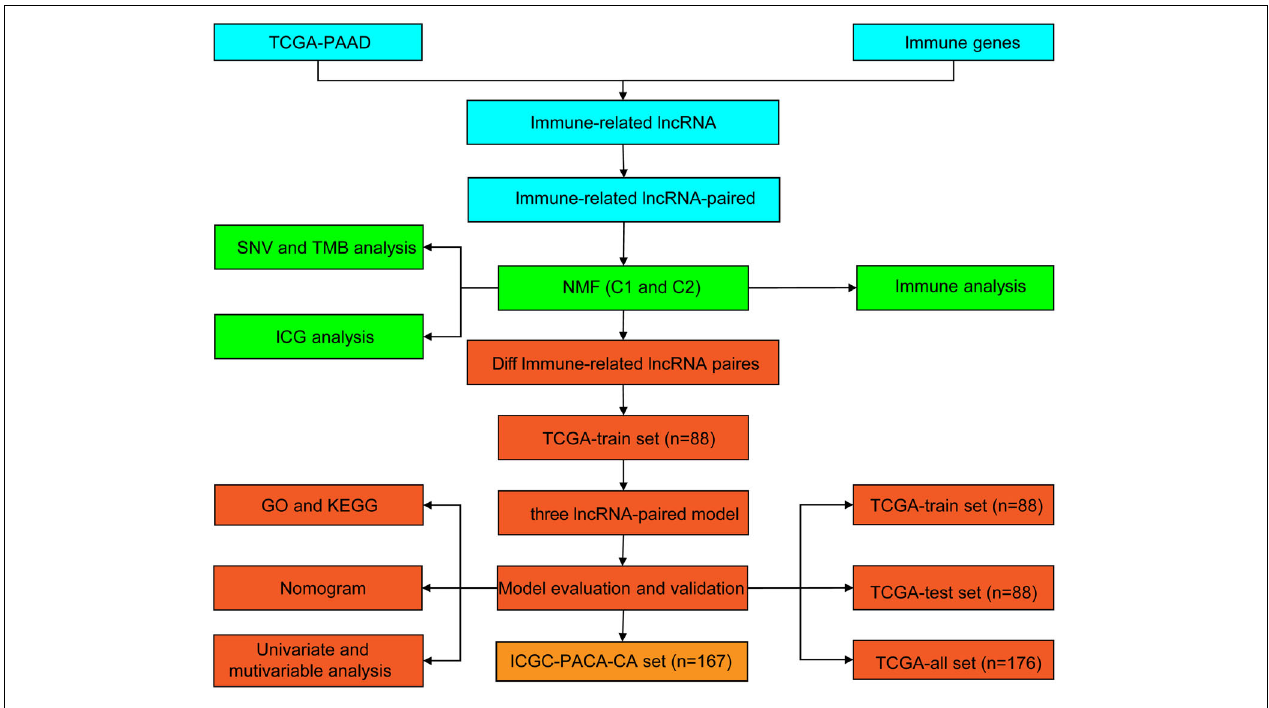
FIGURE 1 | Flowchart of the